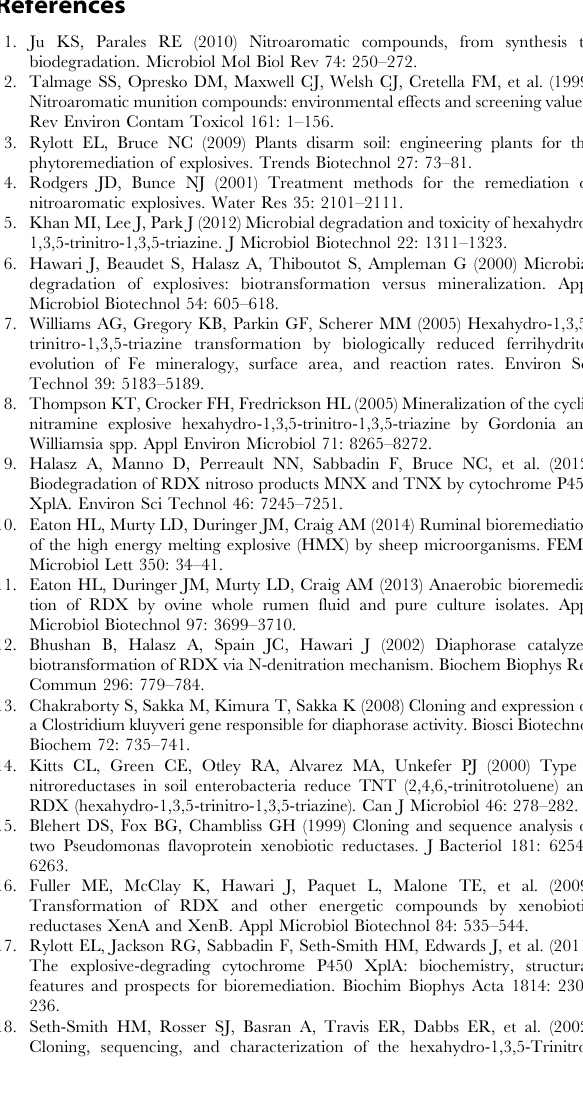
Table S1 Raw counts of Pfam protein families in the ovine rumen microbiome during RDX exposure. Table S2 Raw counts of the KEGG Orthology (KO) categories in the ovine rumen microbiome during RDX exposure. Table S3 The microbial composition of the ovine rumen. The 16S rRNA gene sequences (V3 to V4 regions) were generated using the MiSeq platform (2 6 250 bp, pair-end). The mean number of the 16S raw reads (pairs) per sample is 98,159.50 ( 6 11,376.04, sd). After various quality control procedures, such as chimeric removal, 89,541.00 6 10,903.54 overlapped reads ( . 430 bp in length) were obtained per sample. These reads were then analyzed using both taxonomy-dependent (RDP Classifier) and taxonomy-independent OTU-calling algorithms, such as